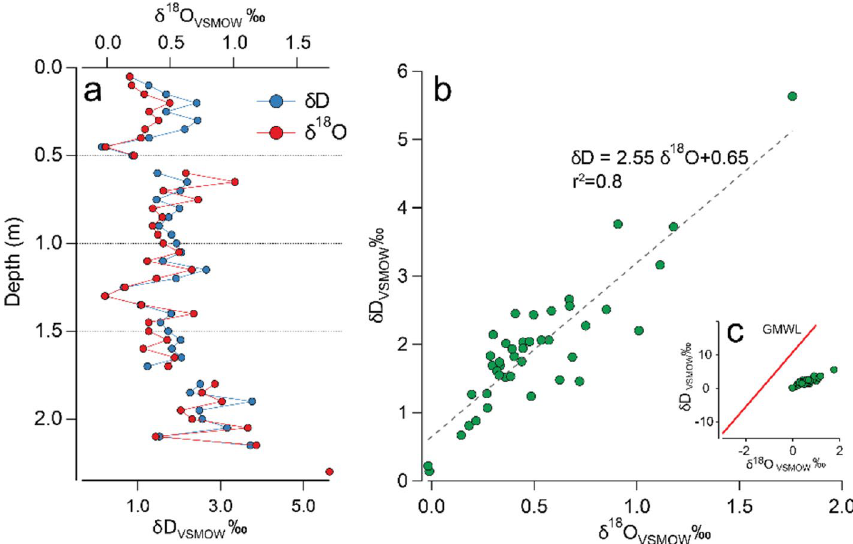
Figure 5. Oxygen (δ 18 O) and deuterium (δD) stable water isotope distribution in sediment from: ( a ) Depth profile of the corer; ( b ) Cross-isotope linear regression of pore water samples and ( c ) Cross-isotope relationship of pore water samples against the global meteoric water